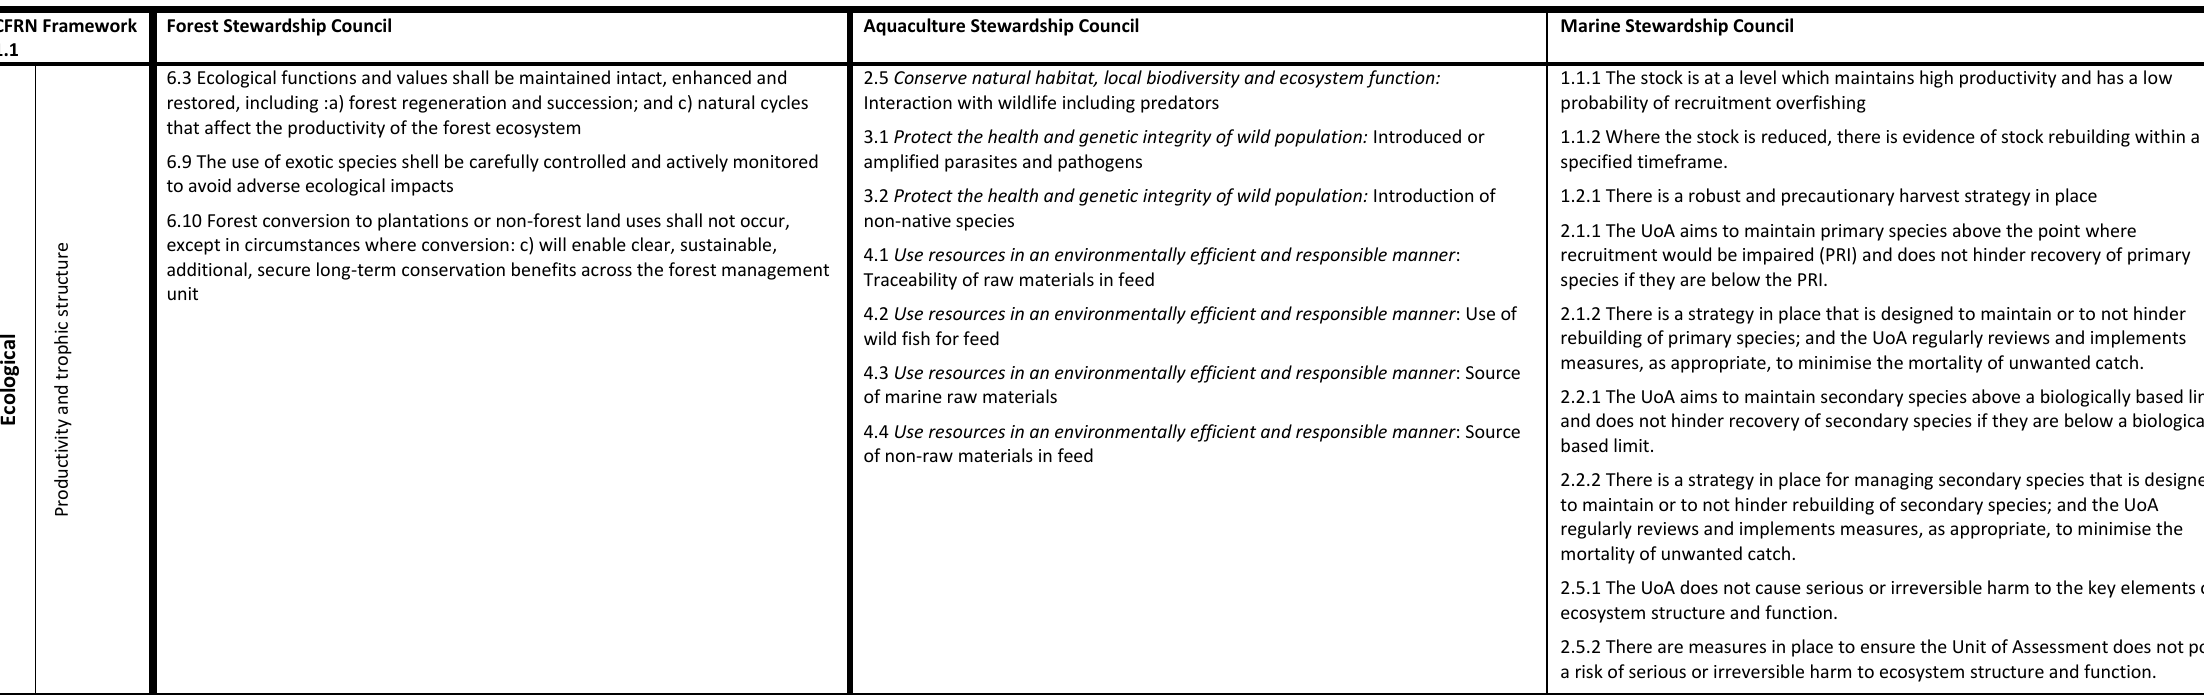
Appendix 1: Detailed comparison of the Canadian Fisheries Research Network framework for comprehensive evaluation of fisheries sustainability (presented in Stephenson et al. 2019b) with